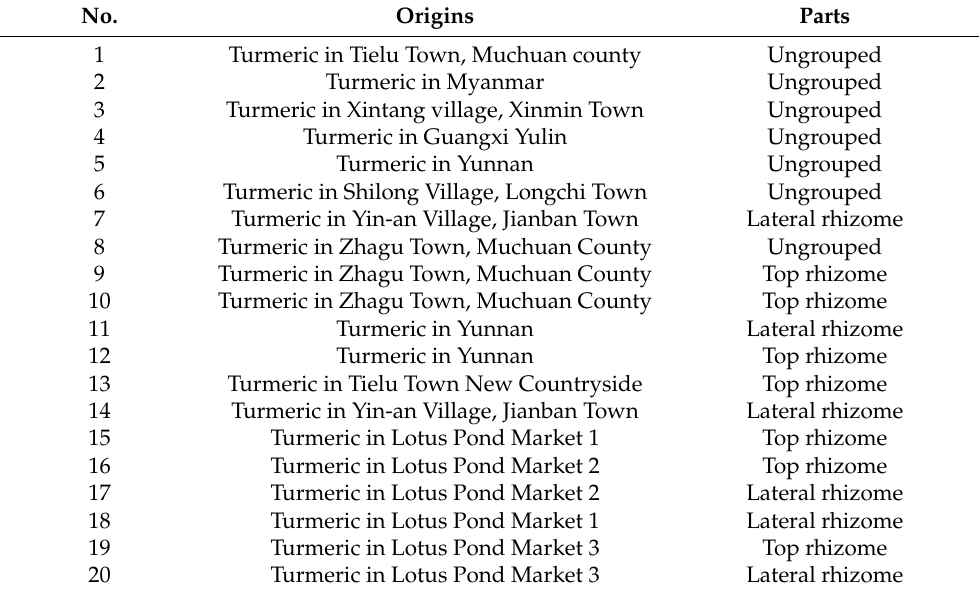
Table 4. Origin and parts of 20 turmeric